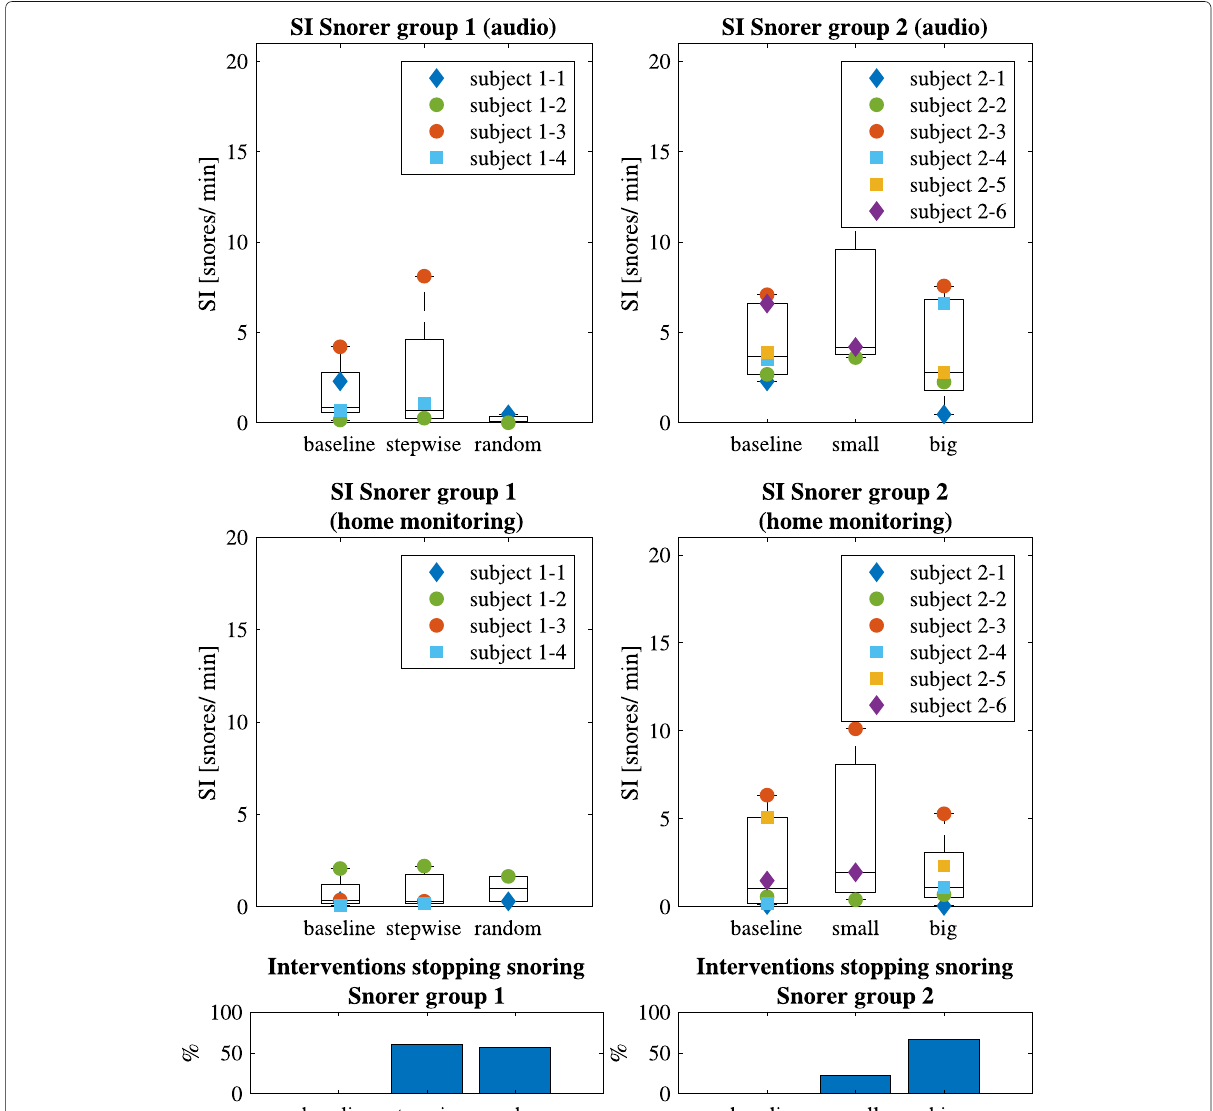
Fig. 3 Effect of the automated bed on snoring. The average SI was once derived from manually scored audio-recording and once from the nasal cannula of the home-monitoring device. As depicted the bed was able to stop snoring with a success rate of 22.2% to 66.6% in different test conditions. However, the successful interventions did not lead to a reduction of the average SI which describes the total amount of snores